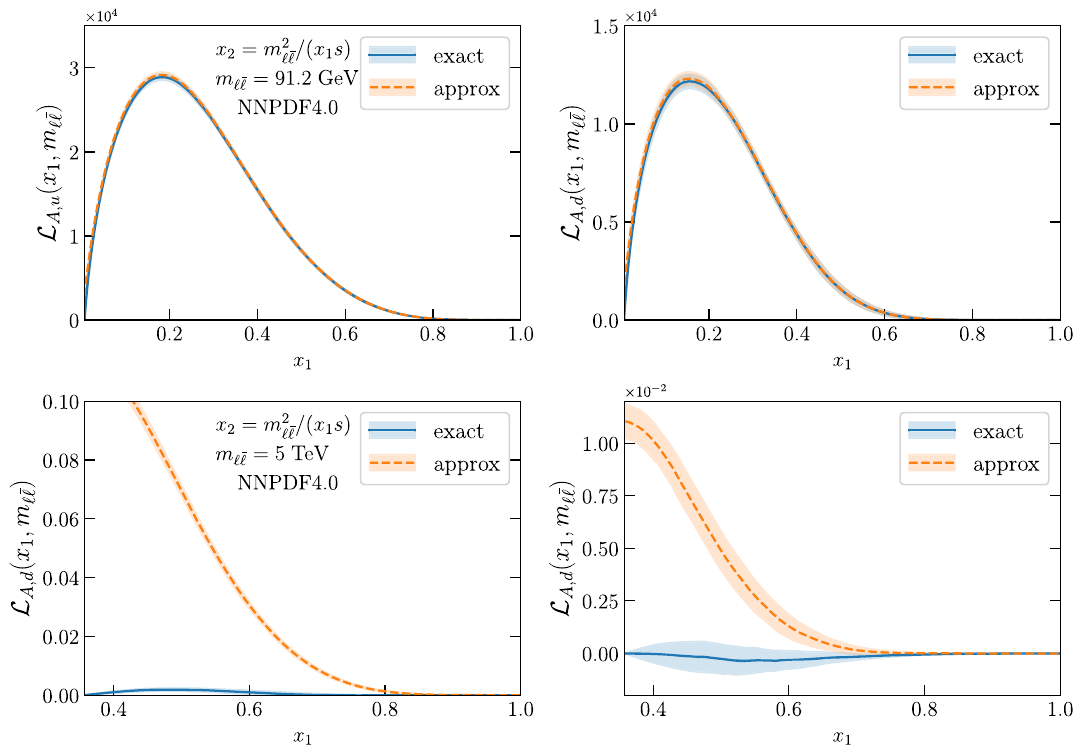
Fig. 7 The antisymmetric partonic luminosity L A , q , Eq. (2.16), for the up and down quarks compared to the approximation Eq. (3.5) in the case of NNPDF4.0 at m (cid:2) ¯ (cid:2) = m Z (top) and m (cid:2) ¯ (cid:2) = 5 TeV (bottom panels)